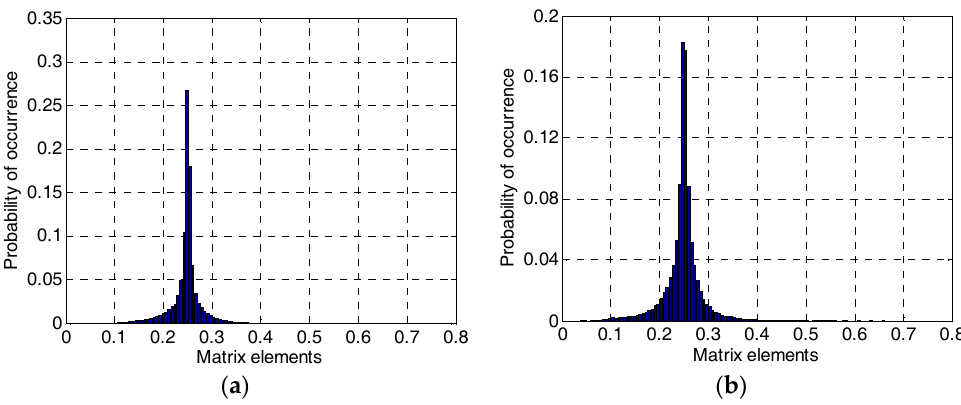
Figure 1. Probability distribution histogram of the values in u 1 v T Barbara.